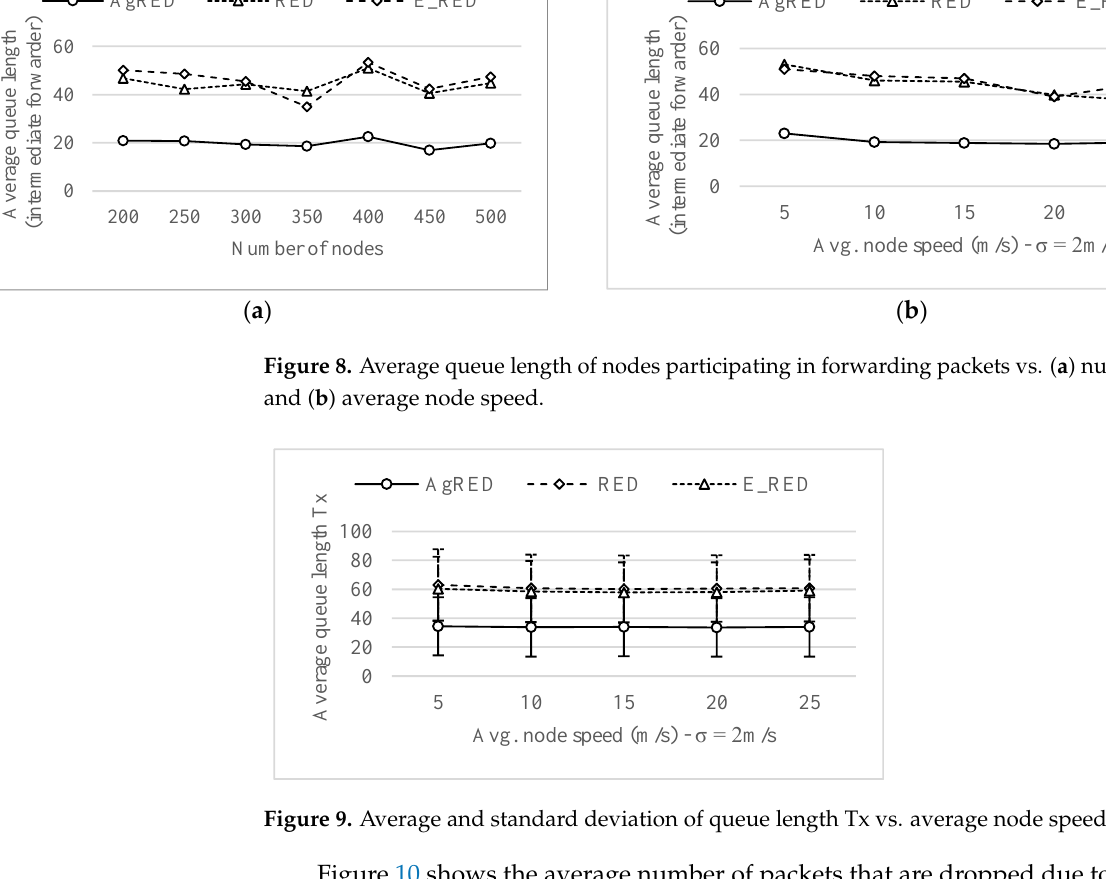
Figure 7. Average queue length of transmitter vs. ( a ) number of nodes and ( b ) average node speed.